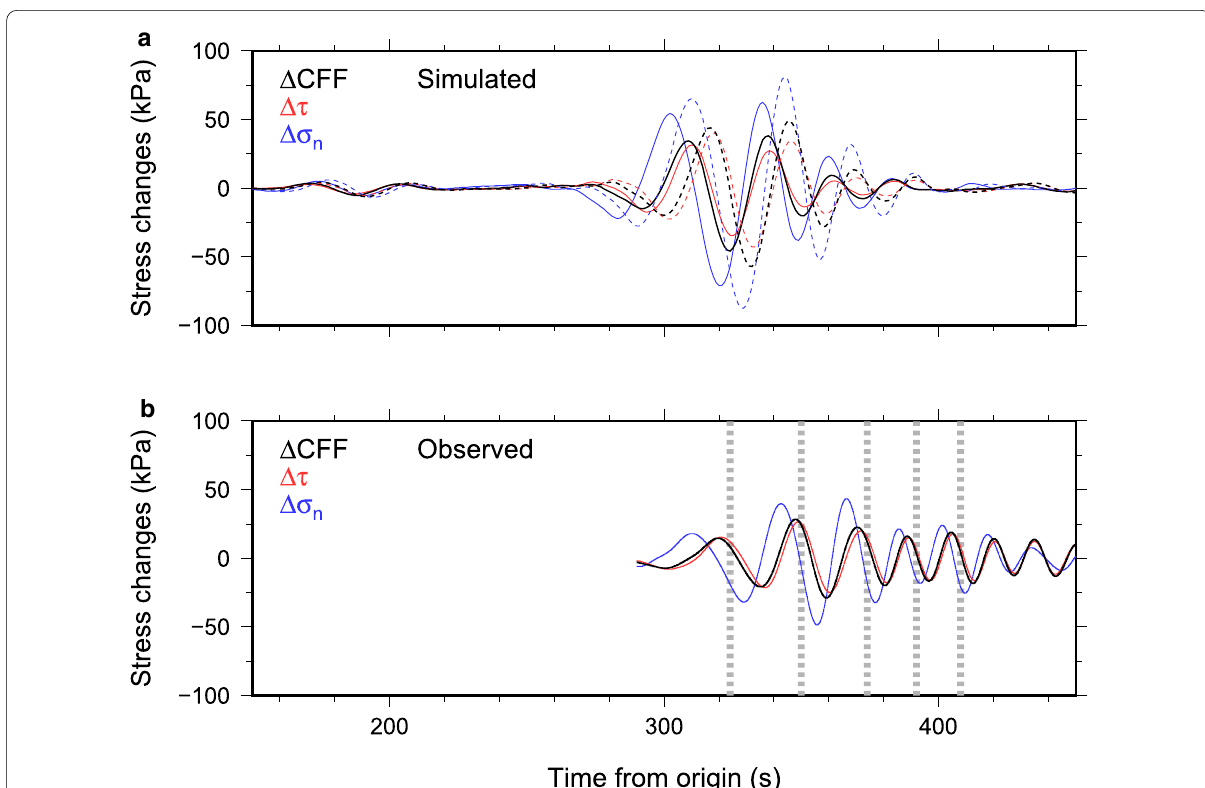
Fig. 4 Stress changes resolved for a mechanism of tremor. Δ σ n represents the normal stress change, Δ τ is the shear stress change in the slip direction, and ΔCFF is the Coulomb failure function change for the shear slip on the plate interface. a Simulated values at the location estimated by the median epicenter of background tremors are shown as solid lines, and those at the location close to CJIG are shown as dotted lines. b Values at a depth of 45 km estimated from the recorded waveforms beneath station CJIG. The vertical dashed lines in gray correspond to the large peaks of triggered tremors shown in Fig. 2